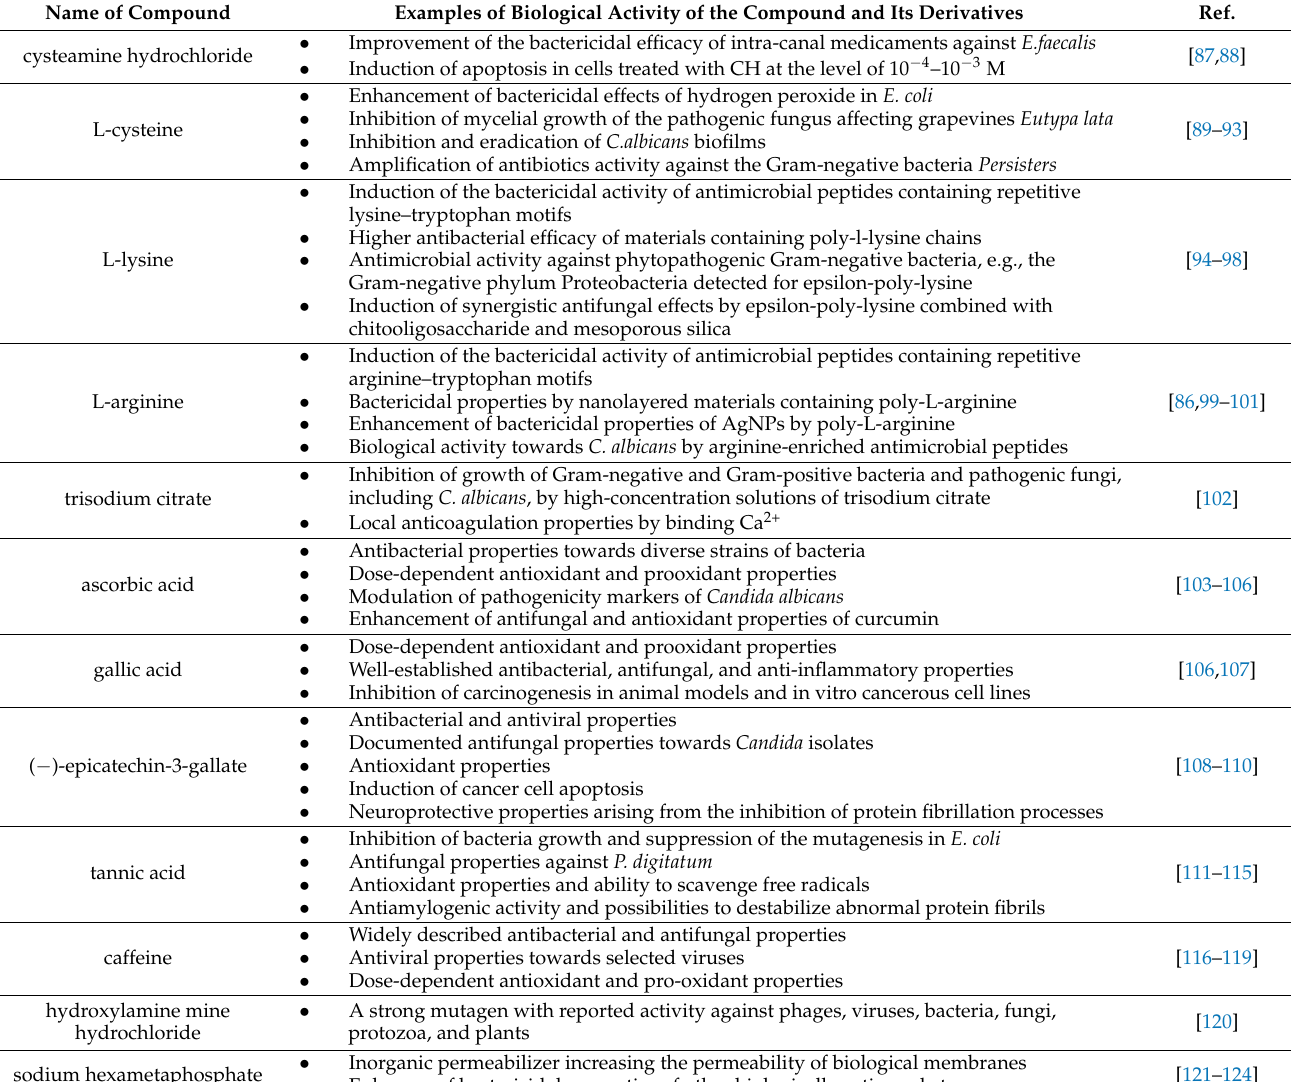
Table 4. Examples of the biological activity of stabilizing agents applied for the preparation of AgNPs. Name of Compound Examples of Biological Activity of the Compound and Its Derivatives